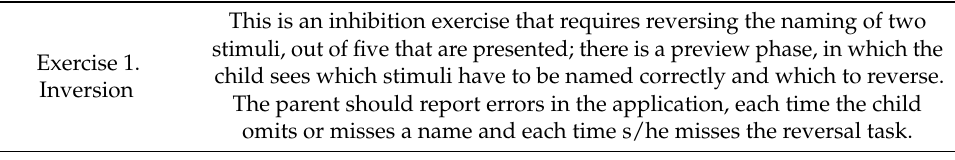
Table 2. Types of exercises presented in